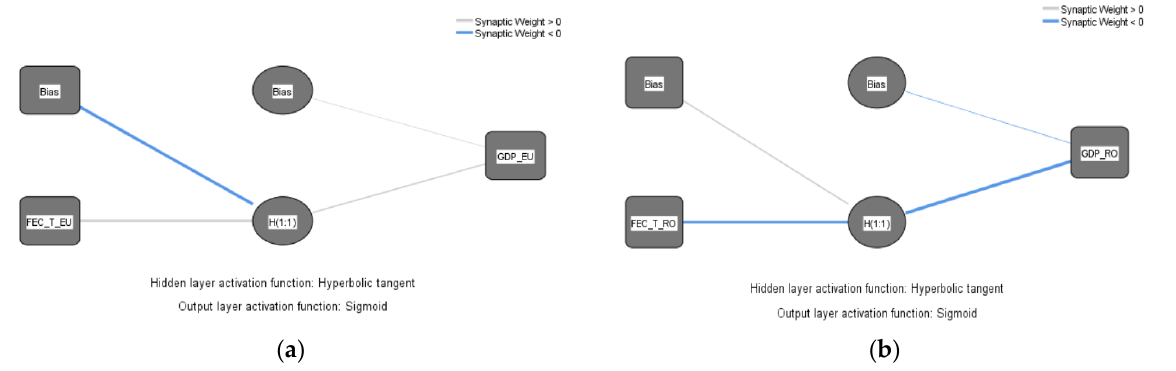
Figure 14. MLP network for identifying the influences of FEC_T on GDP at the EU and RO levels: ( a ) EU; ( b ) RO.